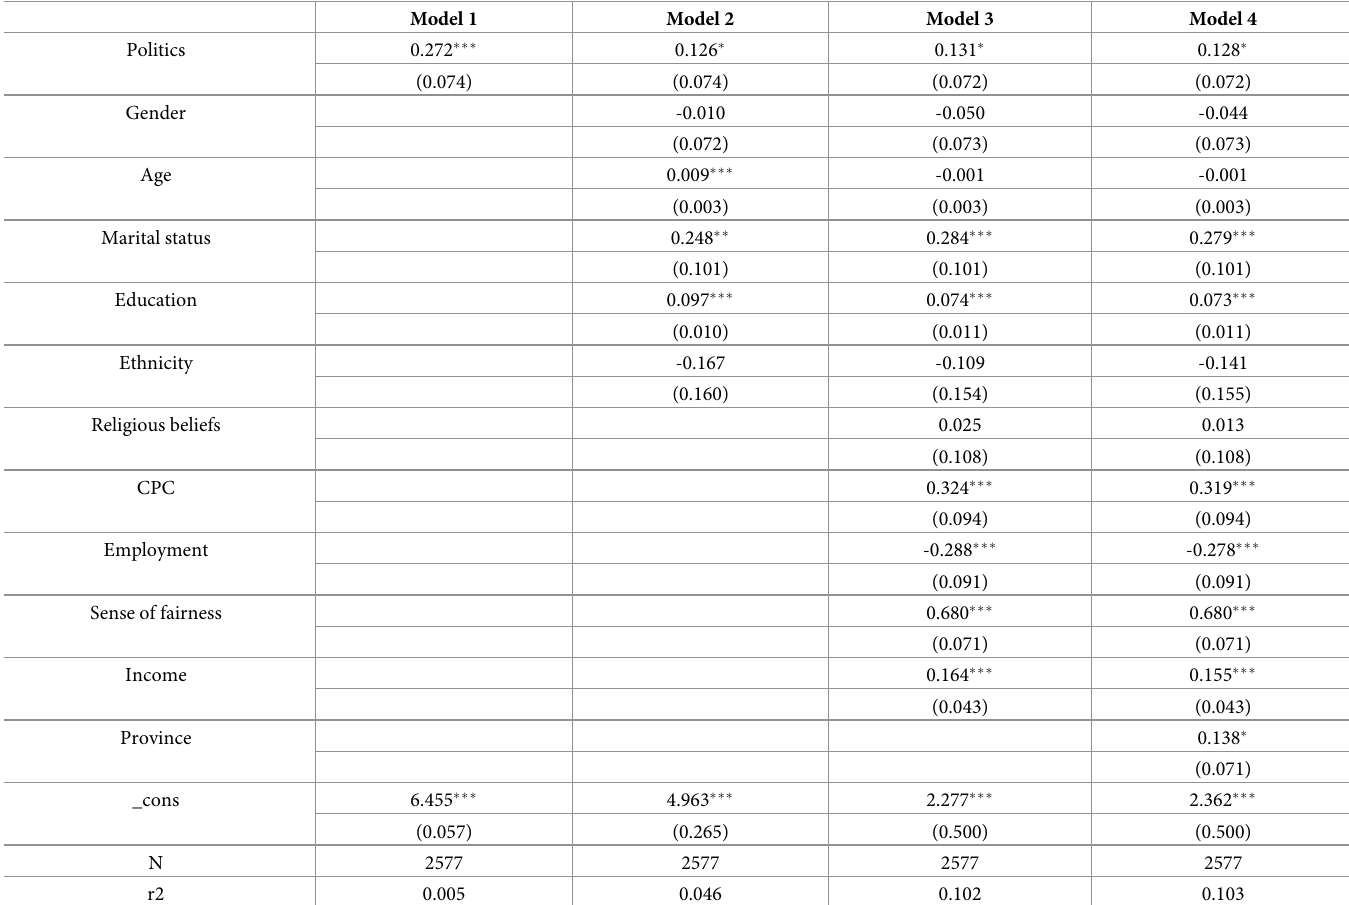
Table 2. Benchmark regression